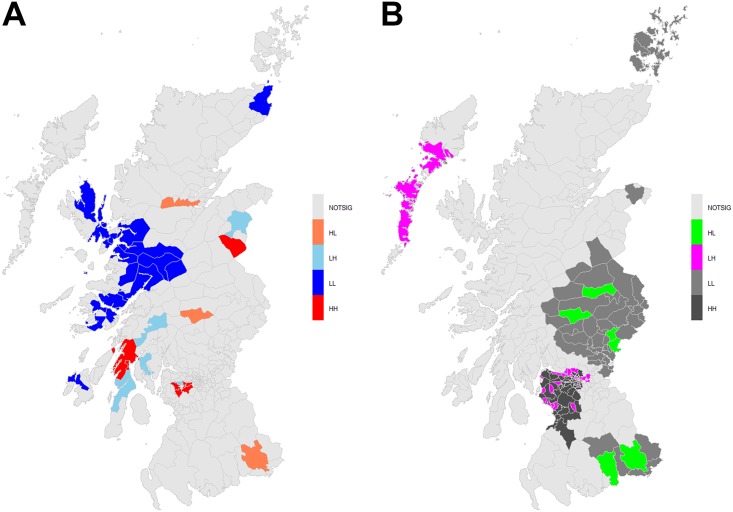
a) Univariate local Moran’s I cluster map of period prevalence (PP) at the district level; b) Bivariate local Moran’s I cluster map of period prevalence (PP) across the district-zone level.Different color schemes are used between a and b to highlight that the univariate and bivariate local Moran’s I are interpreted differently.